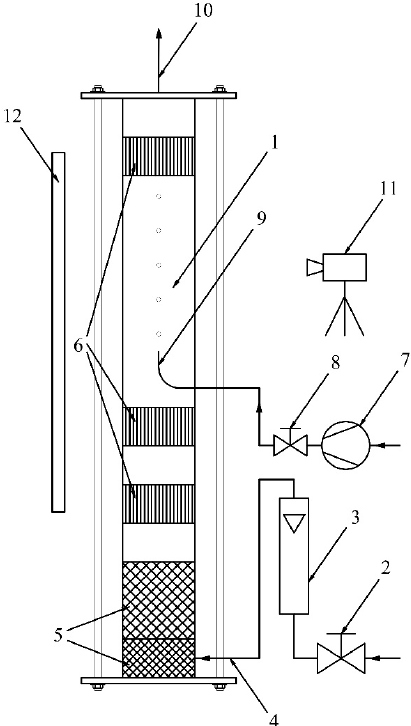
Figure 1. Schematic drawing of the experimental setup. 1—bubbling zone, 2—liquid valve, 3—rotameter, 4—water inlet, 5—Raschig rings, 6—flow straighteners, 7—air compressor, 8—air valve, 9—orifice, 10—water and air outlet, 11—high fps camera connected to PC, and 12—LED backlight.